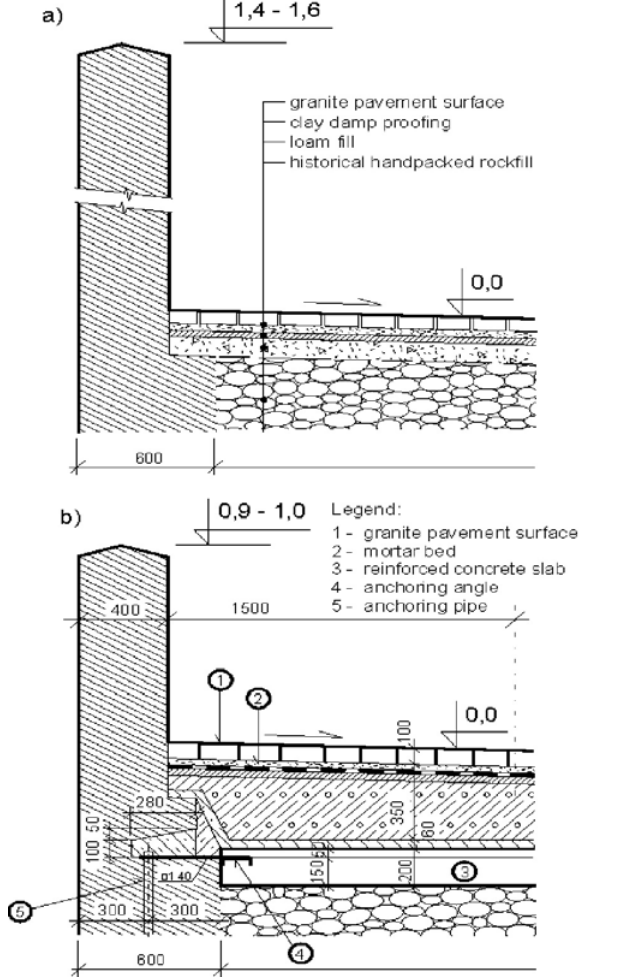
Fig 2. Historical arrangement of the bridge body (according to V. Mencl) (a); a scheme of reinforced concrete slab anchorage in the breast wall (design plan, repair of 1966–1975)